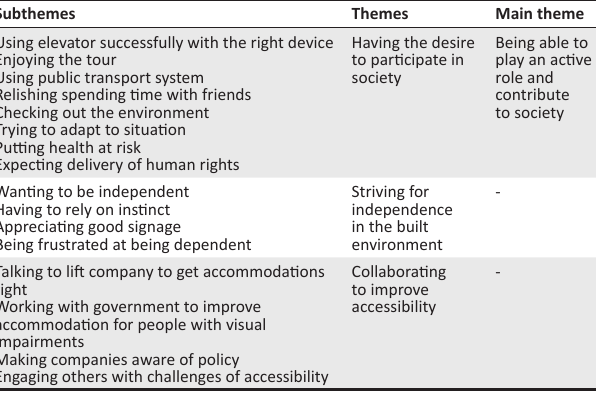
TABLE 4: Sub-themes, themes and main theme from the second structural